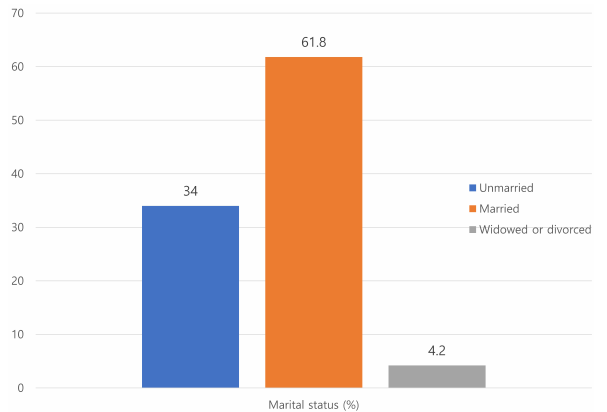
Fig. 2. Marital status of study participants. (%)